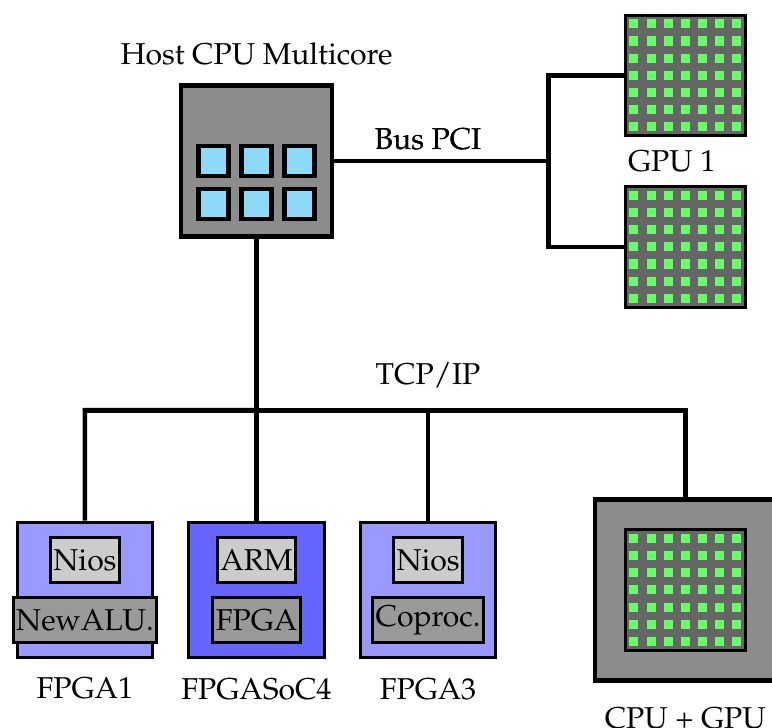
Figure 2. Heterogeneous computational